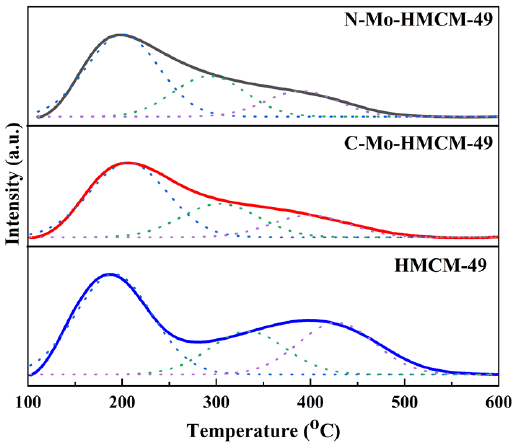
Table 2. The textural properties of HMCM-49 、 C-Mo-HMCM-49 and N-Mo-HMCM-49.